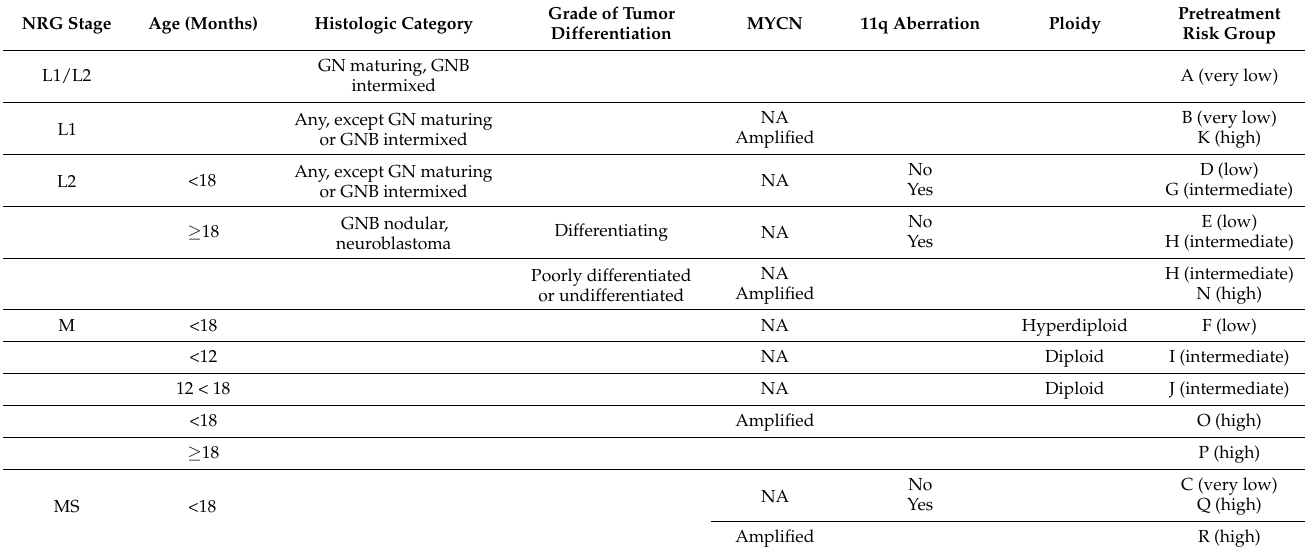
Table 1. International Neuroblastoma Risk Group Pretreatment Classification